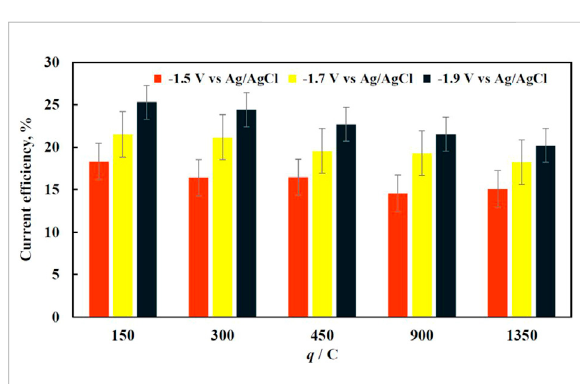
FIGURE 3 The dependence of current ef fi ciency for iron deposition on the amount of charge passed through the electrochemical cell at various applied potentials (marked on the